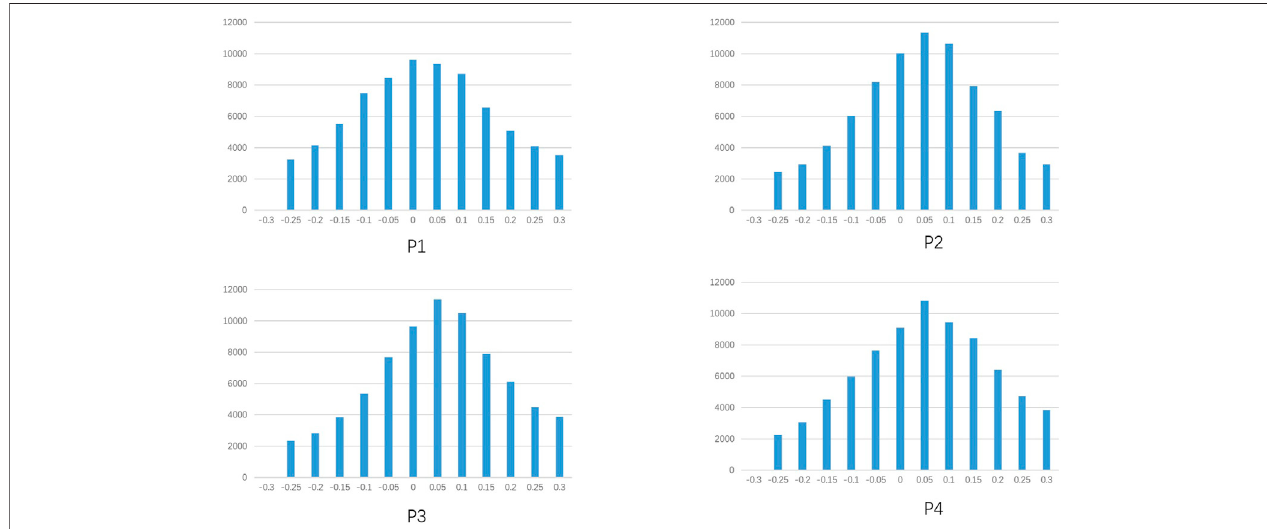
FIGURE 4 | Number distribution of bubble dissipation on the water surface for soil samples with different porosities.